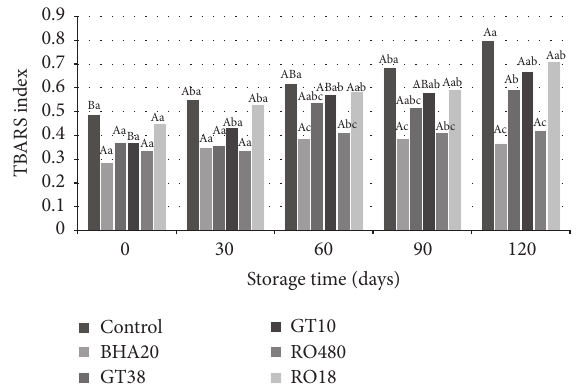
Figure 1: TBARS index mean values of chicken burgers treatments during storage period. Each point represents the mean value ± standard deviation ( 𝑛 = 3 ). For each treatment, averages followed by different capital letters differ significantly ( 𝑝 ≤ 0.05 ) during storage time (see the same treatment during different storage times) and for each storage time, averages followed by different lowercase letters differ significantly per treatment (see the different treatments in the same storage time) ( 𝑝 ≤ 0.05 ) by the Tukey HSD